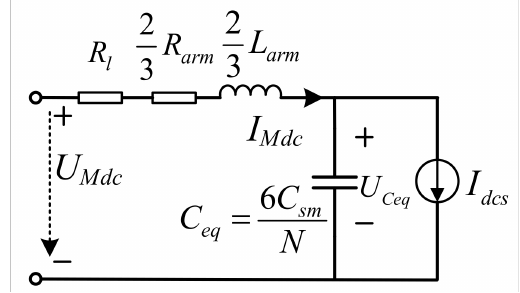
Figure 5. Equivalent circuit diagram of MMC DC side